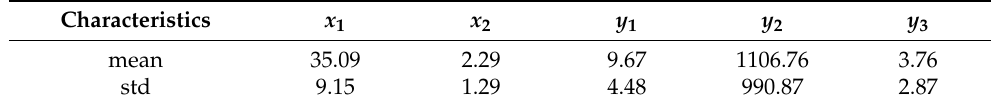
Table 1. The dataset LifeCycleSavings , the means and standard deviations.